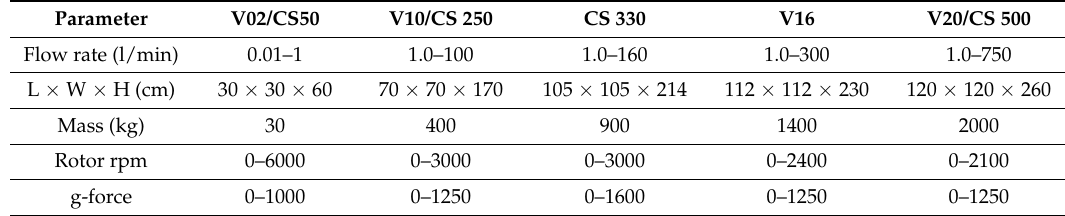
Table 1. Current model range of CINC extractive centrifuges [22].